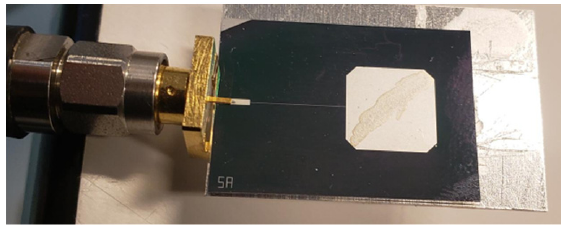
Figure 6. A photograph of the first prototype.